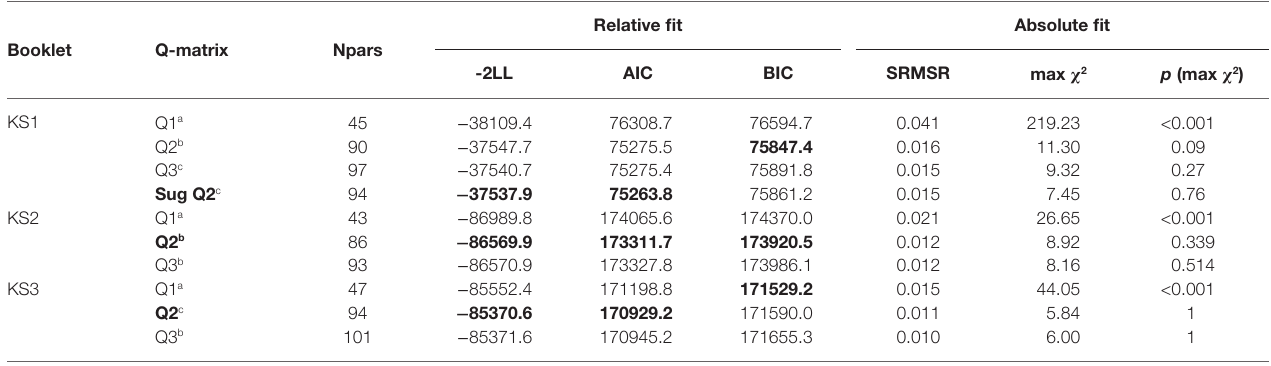
TABLE 3 | Model-data fitting results for Q-matrix